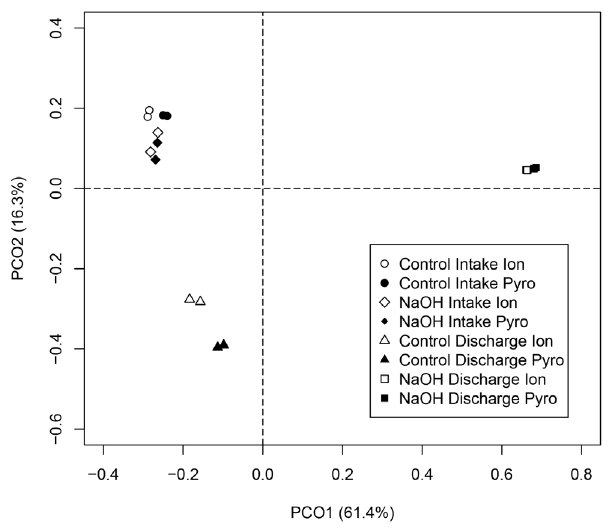
Figure 3. PCoA plot depicting a comparison of microbial communities derived from Ion Torrent and pyrosequencing. RDP multiclassifier with 60% threshold was used to identify microbial taxa in each sample at genus level. PCoA plot was generated using Bray-Curtis dissimilarity matrix. Taxa that had the relative abundance of 0.5% or greater at least one of the samples were used to generate the matrix. The values in the parentheses indicate the percentage of eigenvalues for each